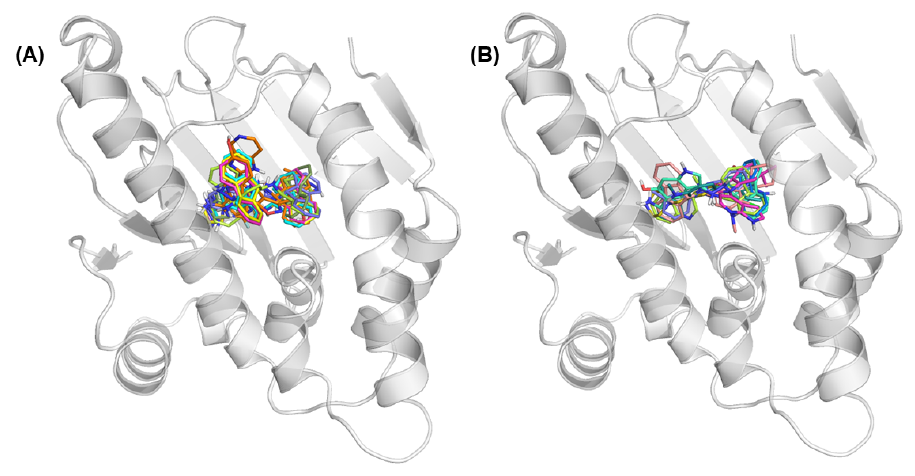
Figure 10. Best docking position for each new ligand obtained by ( A ) semi-exhaustive approach and ( B ) heuristic search